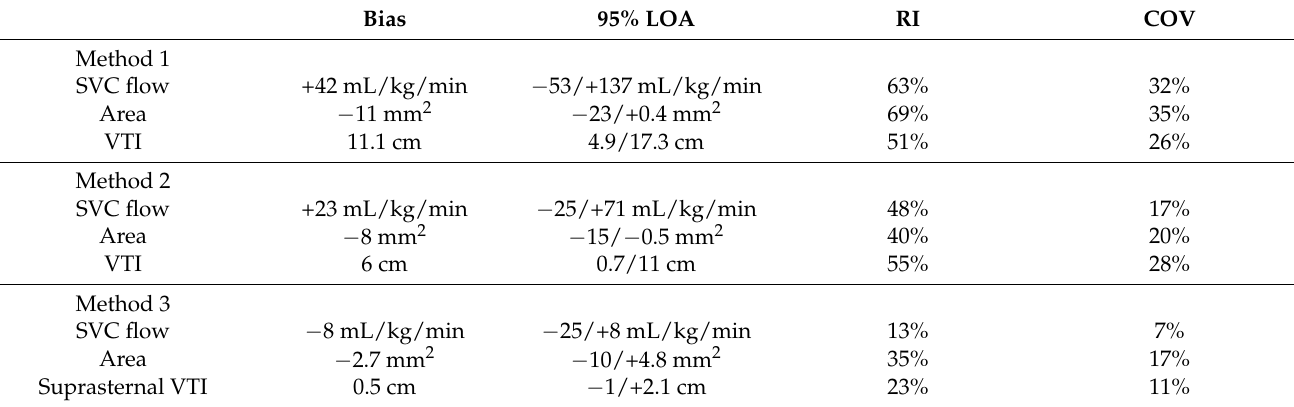
Table 4. Agreement between PCMRI and the three echocardiographic techniques of SVC flow